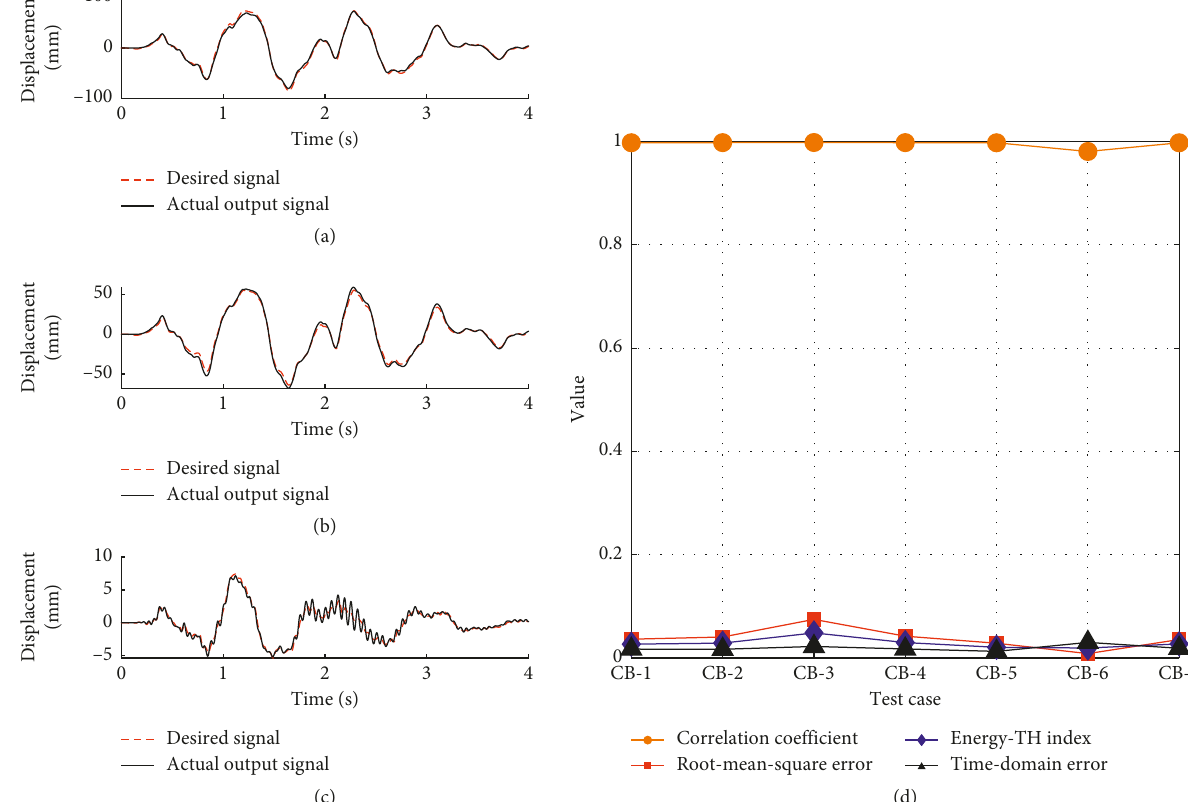
Figure 23: Shake table’s output and corresponding error of different test cases with collision of adjacent multispan bridges. (a) Case CB-1; (b) case CB-3; (c) case CB-5; (d) output error of test